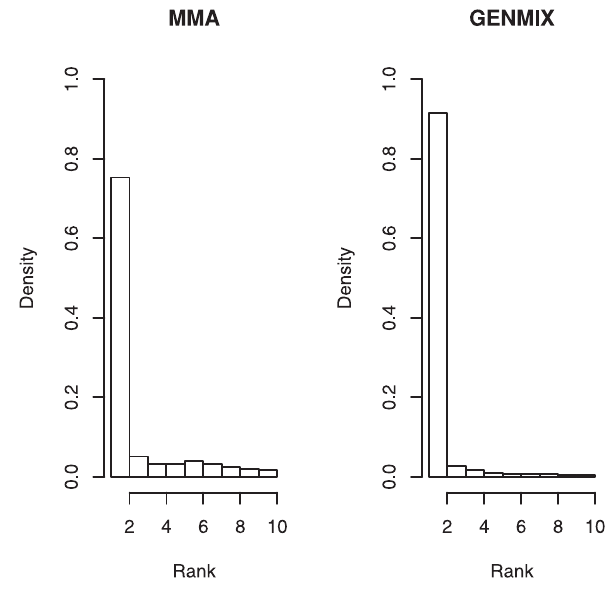
Figure 2. Distribution of the highest-ranking marker within a 1 Mbp radius of a quantitative trait nucleotide with MAF=0.10 for 375 replicates (3 h 2 x 5 QTL effects x 25 replicates).